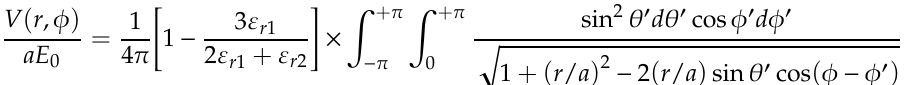
(b) Figure 15. ( a ) Dipole electric charge and electric line of force distributions near spherical dielectric induced by an electric field E 0 , ( b ) The spherical dielectric is present in the base dielectric material. The surface charge density σ